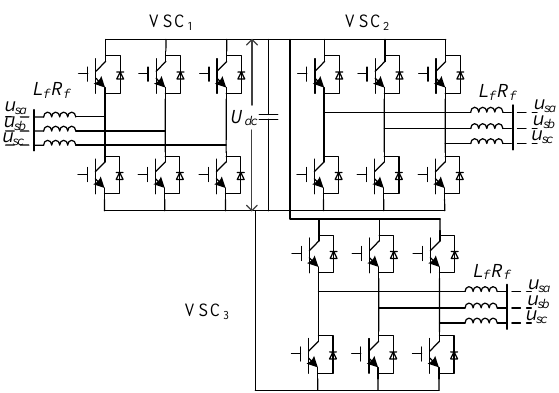
Figure 2. Three-terminal soft open point.